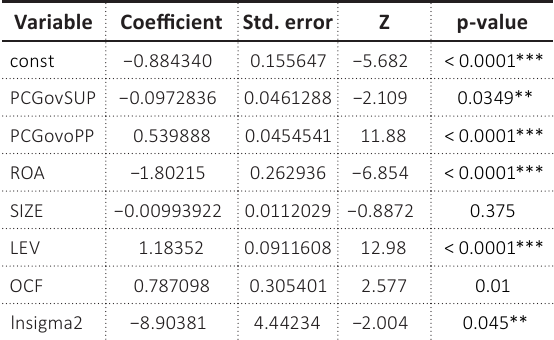
Table 2. Model 1, random effects probit model,